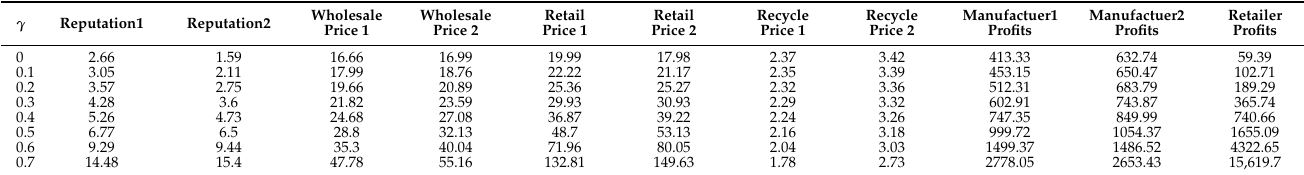
Table 3. Impact of price competition intensity on optimal decision making in closed-loop supply chains.